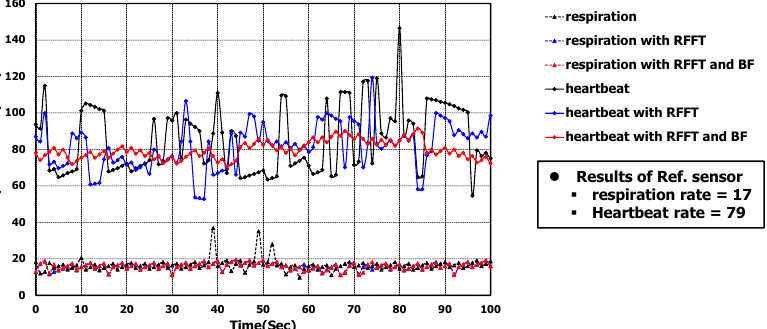
Figure 14. Comparison of algorithm performance with interferer.